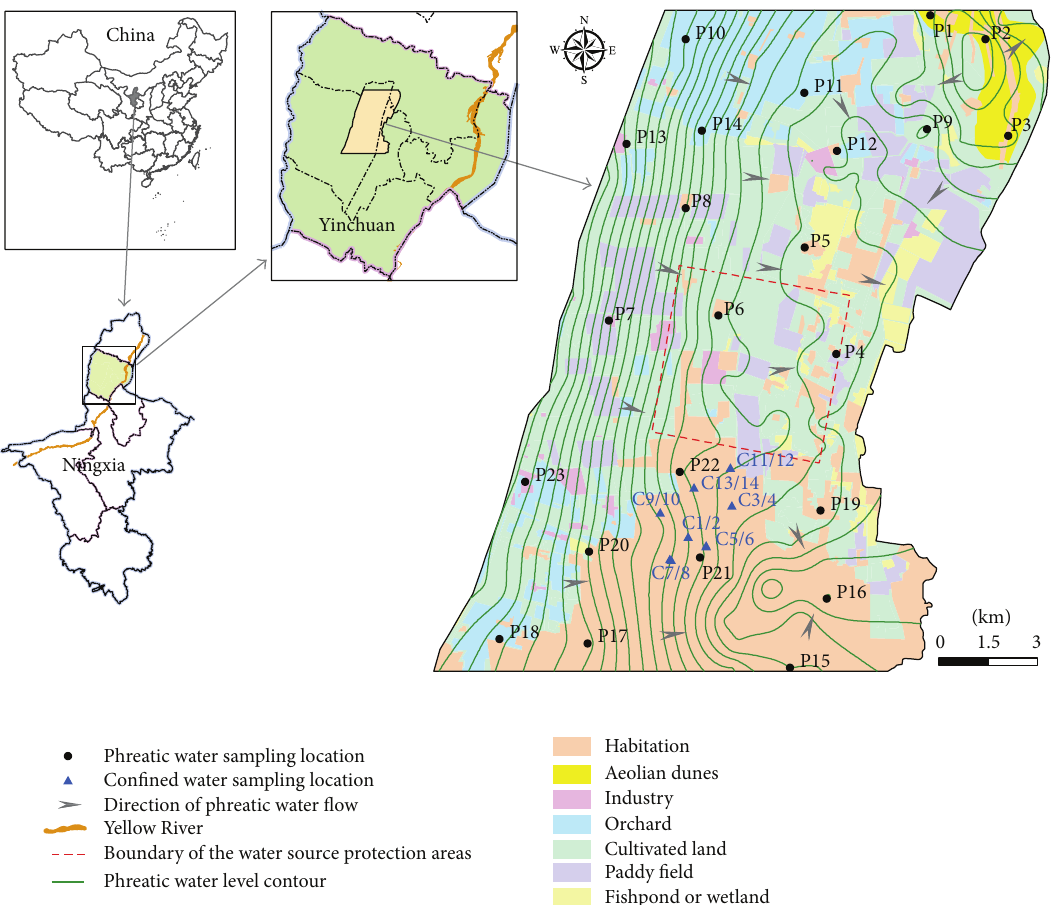
Figure 1: Location map of the study area showing the phreatic water level contour (interval of 1m) and flow direction, land-use type, and sampling